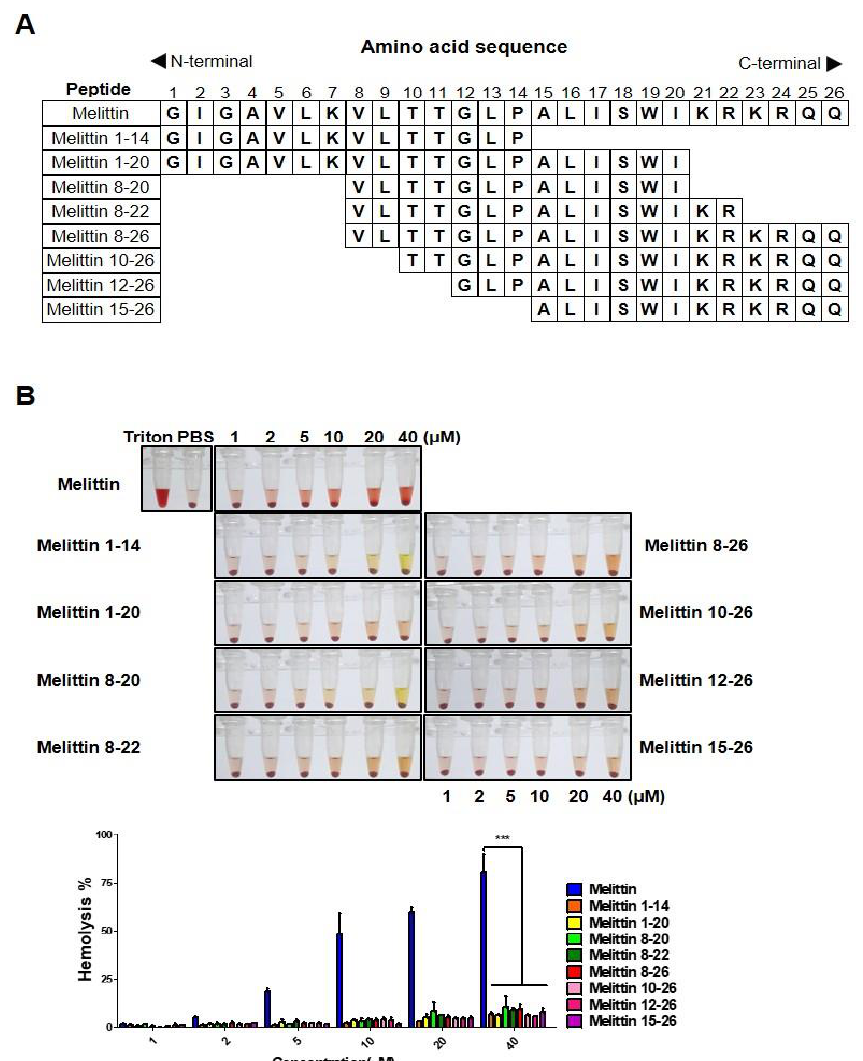
Figure 2. Melittin fragments have fewer hemolytic effects than melittin. ( A ) Amino acid sequence of melittin and melittin-truncated peptide. ( B ) Hemolysis of red blood cells treated with FITC-conjugated melittin or FITC- conjugated melittin fragments at concentrations ranging from 1 μM to 40 μM and incubated at 37 °C for 4 h. 2% Triton-X 100-treated cells were used as the positive control, and PBS-treated cells were used to as the negative control. The optical density of hemoglobin released supernatant was measured at 450 nm. All data are presented as the mean ± SEM; *** p < 0.001 versus melittin (n = 3).